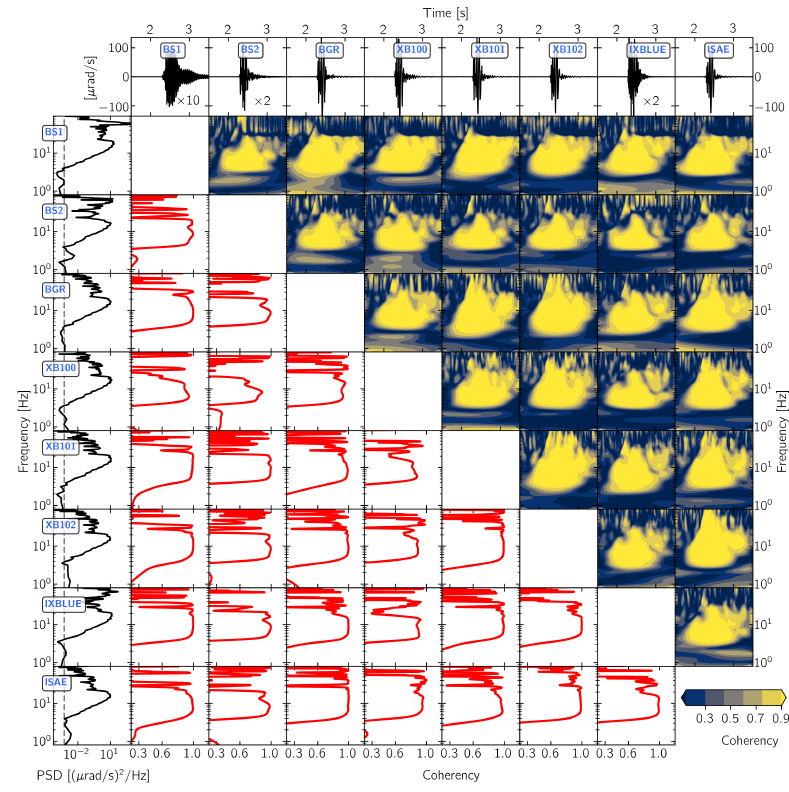
Figure 5. Waveform coherency for pairs of 3C rotational seismometers. The North component recording from explosion “expl2” on 19 November 2019 at 15:16:45 UTC (see Figure 1) is shown. The first row displays the raw waveforms and the first column displays the corresponding power spectral densities with the dashed line indicating the sensor self-noise level. The red graphs in the lower diagonal half represent Fourier-domain coherency spectra. The upper diagonal half shows time resolved wavelet coherency